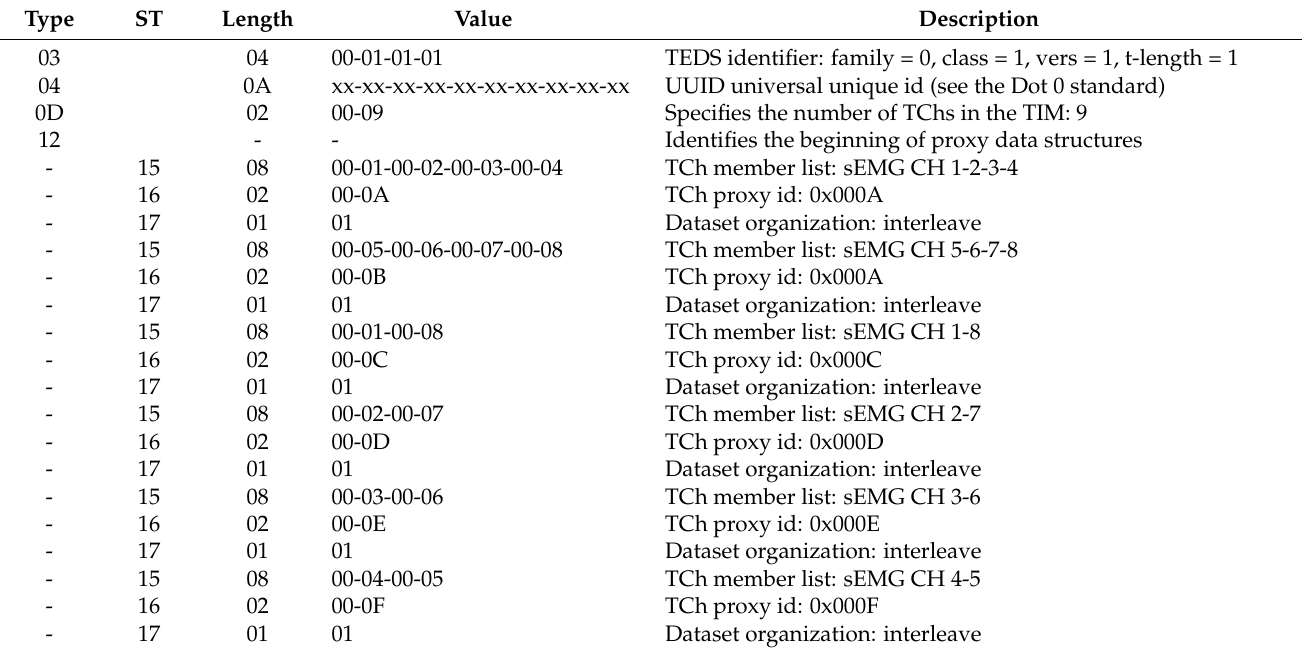
Table 1. Example of data block for the Meta TEDS related to sensing systems illustrated in Figure 4. Data are represented as hexadecimal numbers; xx represents a generic hexadecimal